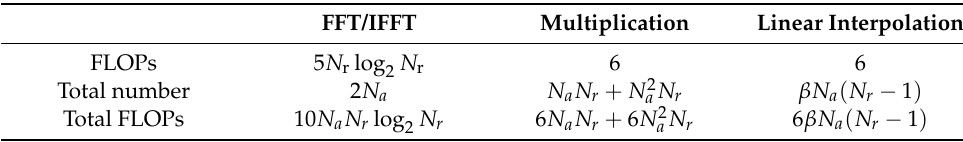
Table 1. Basic operations used by presented method.